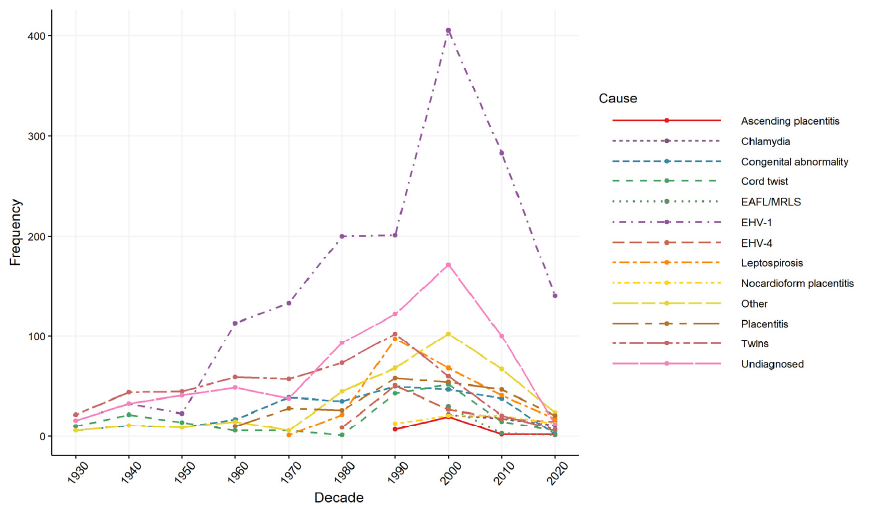
Figure 4. Causes of equine pregnancy loss by the decade of data collection from 514 studies captured from a scoping review of the reported causes and syndromes associated with mid to late-term pregnancy loss in horses.